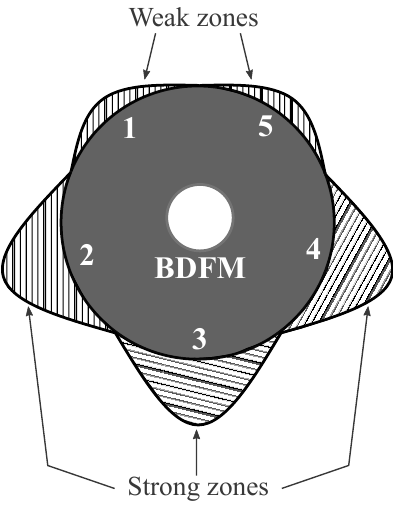
Figure 8. Force diagram for p 1 / p 2 = 2/3 (adapted from [34]).